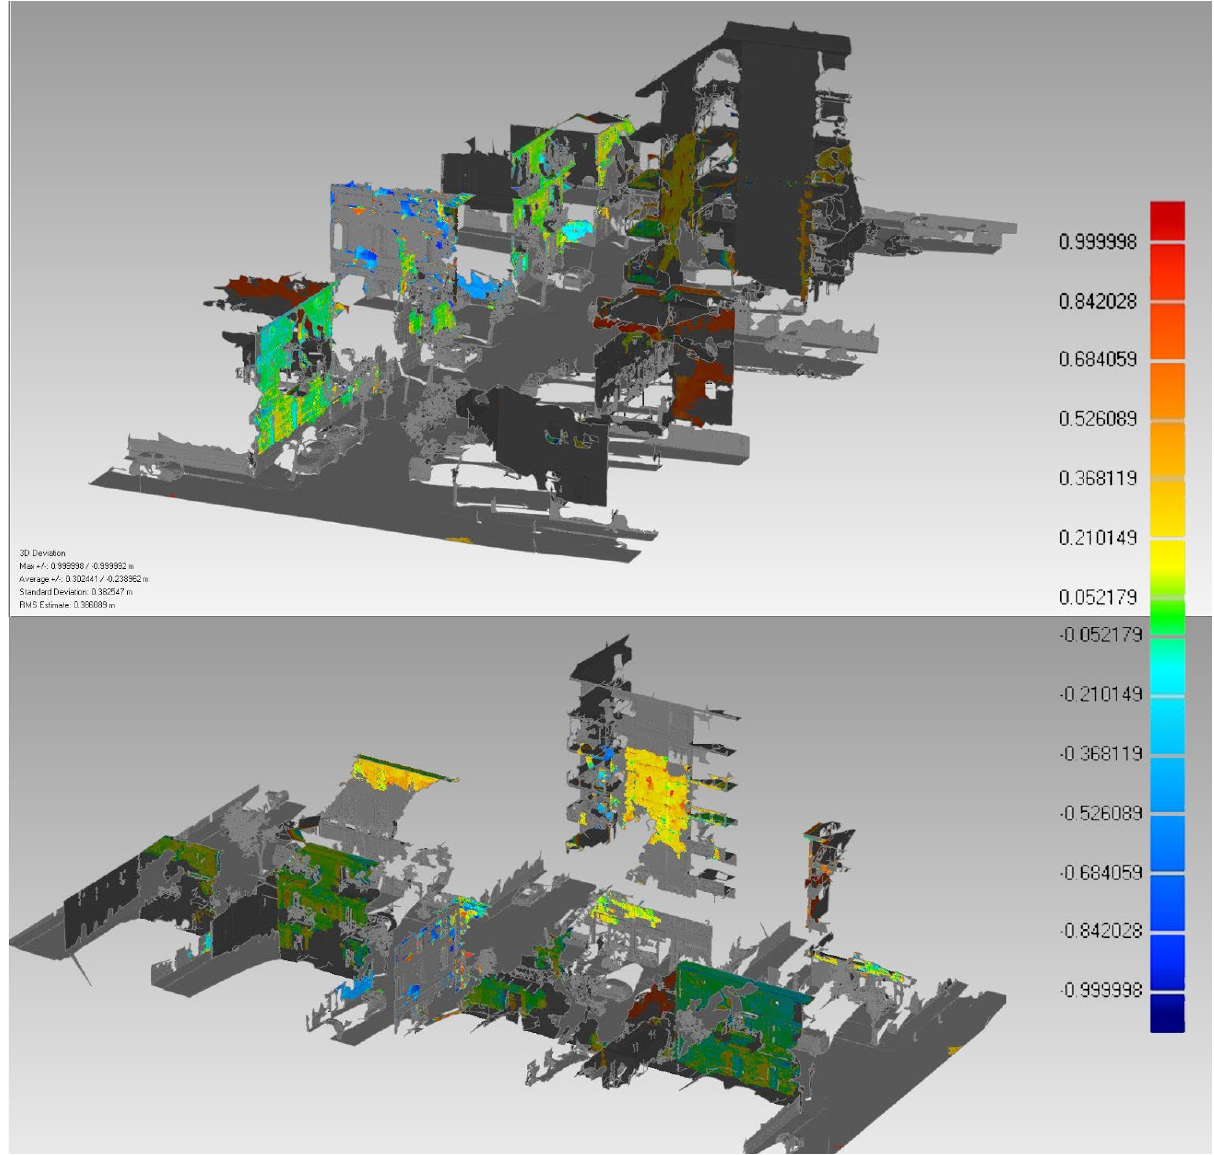
Figure 6: Standard deviation scheme: Point cloud from SLR camera panorama compared to laser scanner point